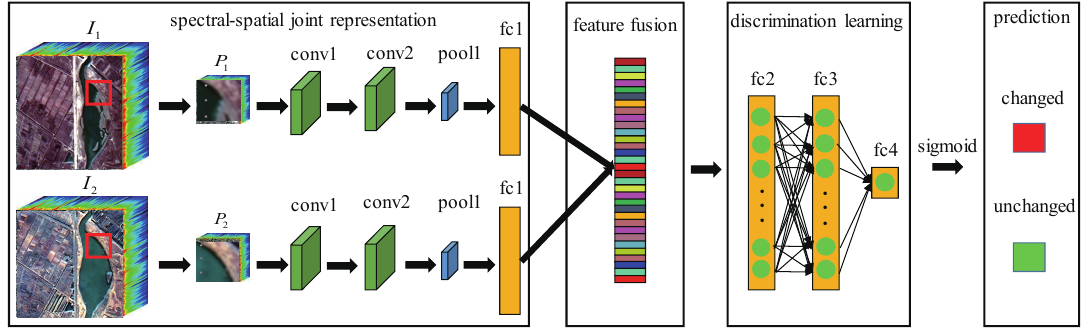
Figure 1. Flowchart of our proposed spectral-spatial joint learning